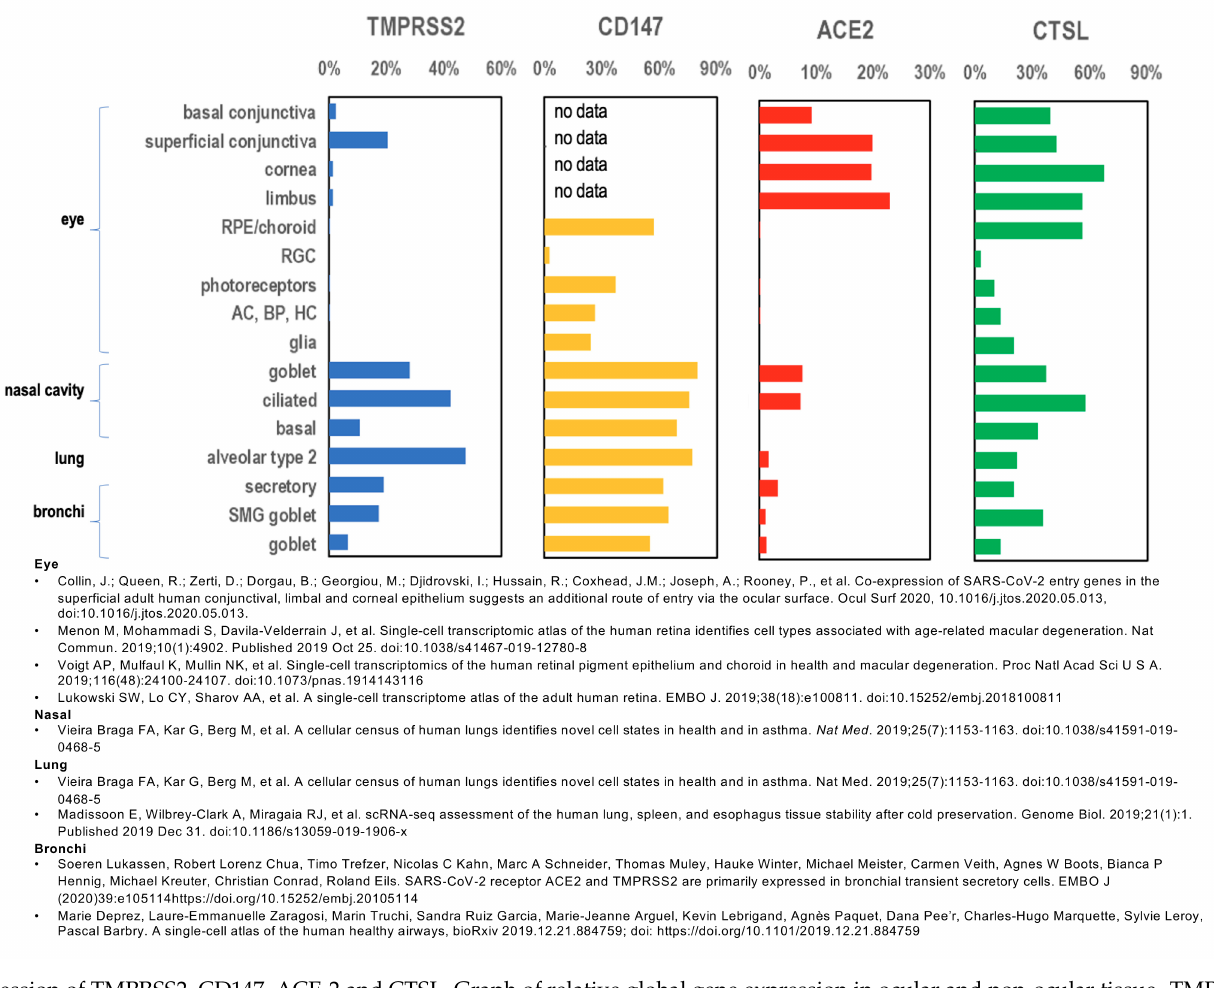
Figure 3. Gene expression of TMPRSS2, CD147, ACE-2 and CTSL. Graph of relative global gene expression in ocular and non-ocular tissue. TMPRSS2, CD147, ACE-2 and CTSL are all expressed in ocular tissues and non-ocular tissues that are currently accepted as sites for SARS-CoV-2